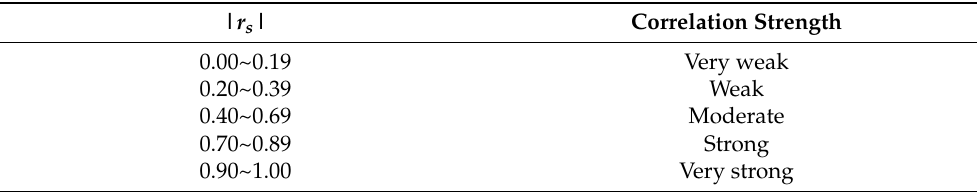
Table 2. The correlation strength described by the absolute value of r s